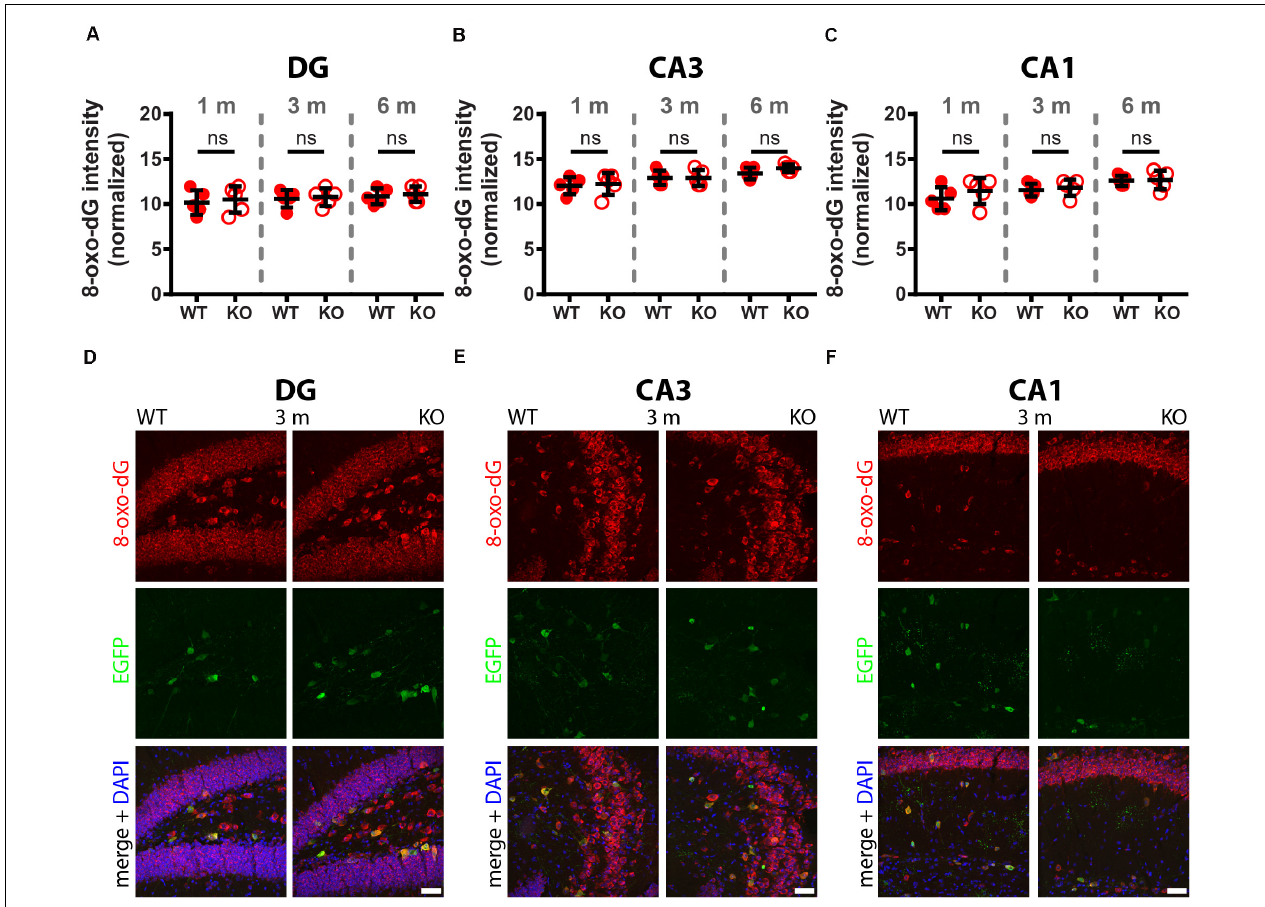
FIGURE 2 | Comparison of 8-oxo-dG signal intensity between WT and KO mice in hippocampal regions of 1, 3, and 6-months old mice. The 8-oxo-dG fluorescence signal intensities (a.u.) analyzed in DG (A) , CA3 (B) , and CA1 (C) were normalized, taking into consideration the different sizes and morphologies of Pvalb neurons. Representative images with immunofluorescence labeling for 8-oxo-dG (red), EGFP (green) and merged images with DAPI (blue) are shown for DG (D) , CA3 (E) and CA1 (F) regions of 3-months old WT (left panels) and KO (right panels) mice. Scale bars: 50 µ m. Each dot in the graphs represents the average obtained in 1 animal (5 mice per genotype) and at least 15 cells per animal resulting in > 75 cells per brain region (DG, CA3, CA1) and genotype. No significant differences were observed between WT and KO mice, ns – not significant. Values are reported in Table 1